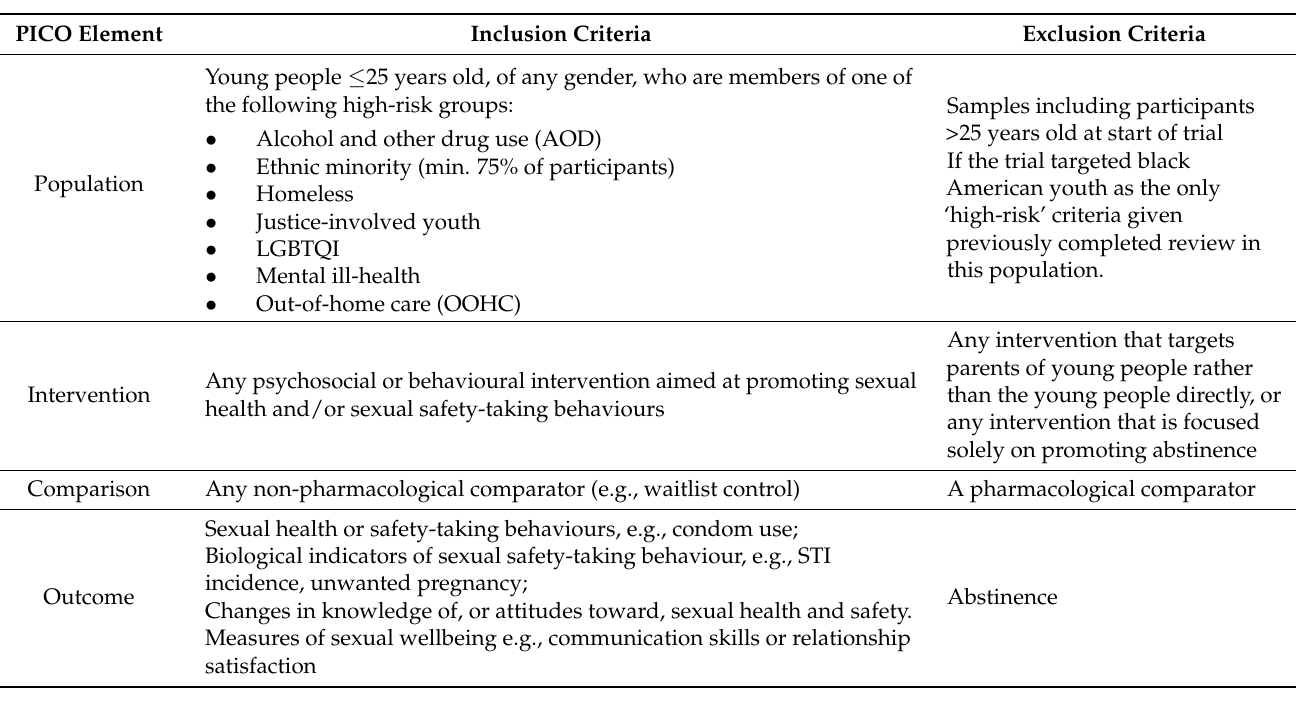
Table 1. PICO inclusion